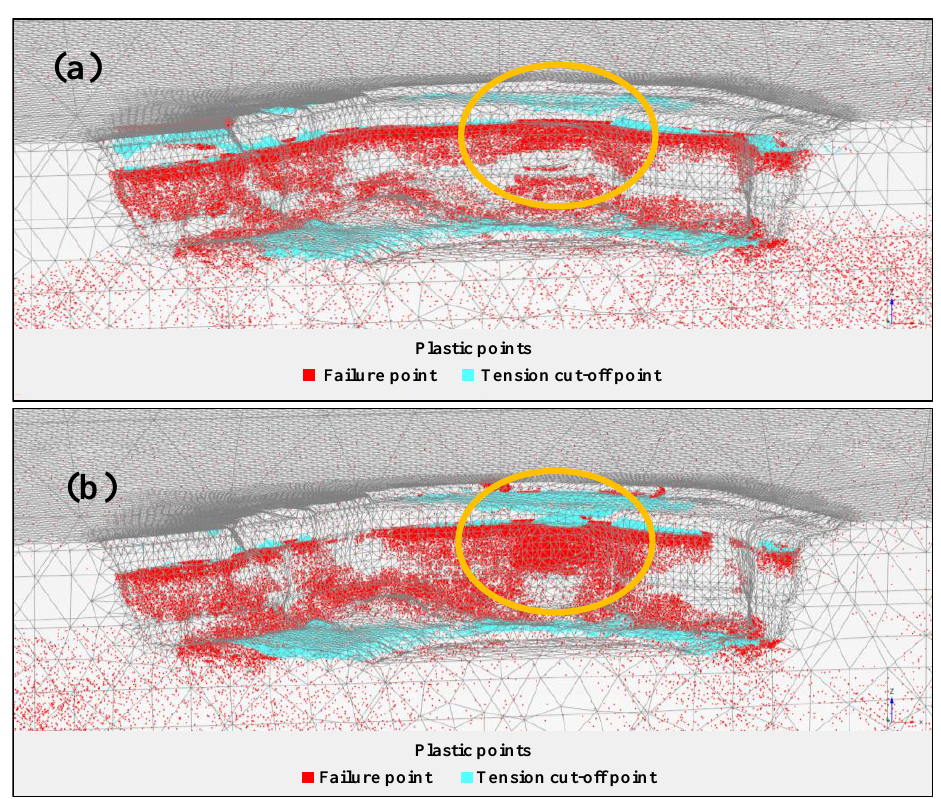
Figure 14. Plastic points distribution: ( a ) pre- and ( b ) post- rock block detachment.